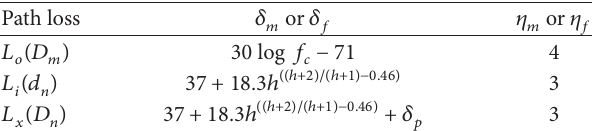
Table 2: Path loss parameters